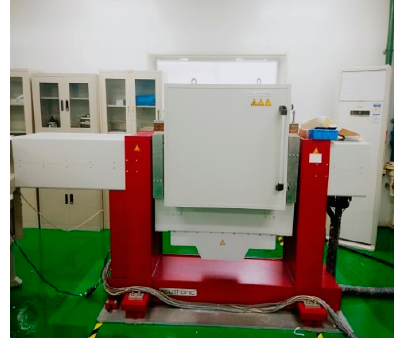
Figure 7. The low-precision 2-axis turntable.